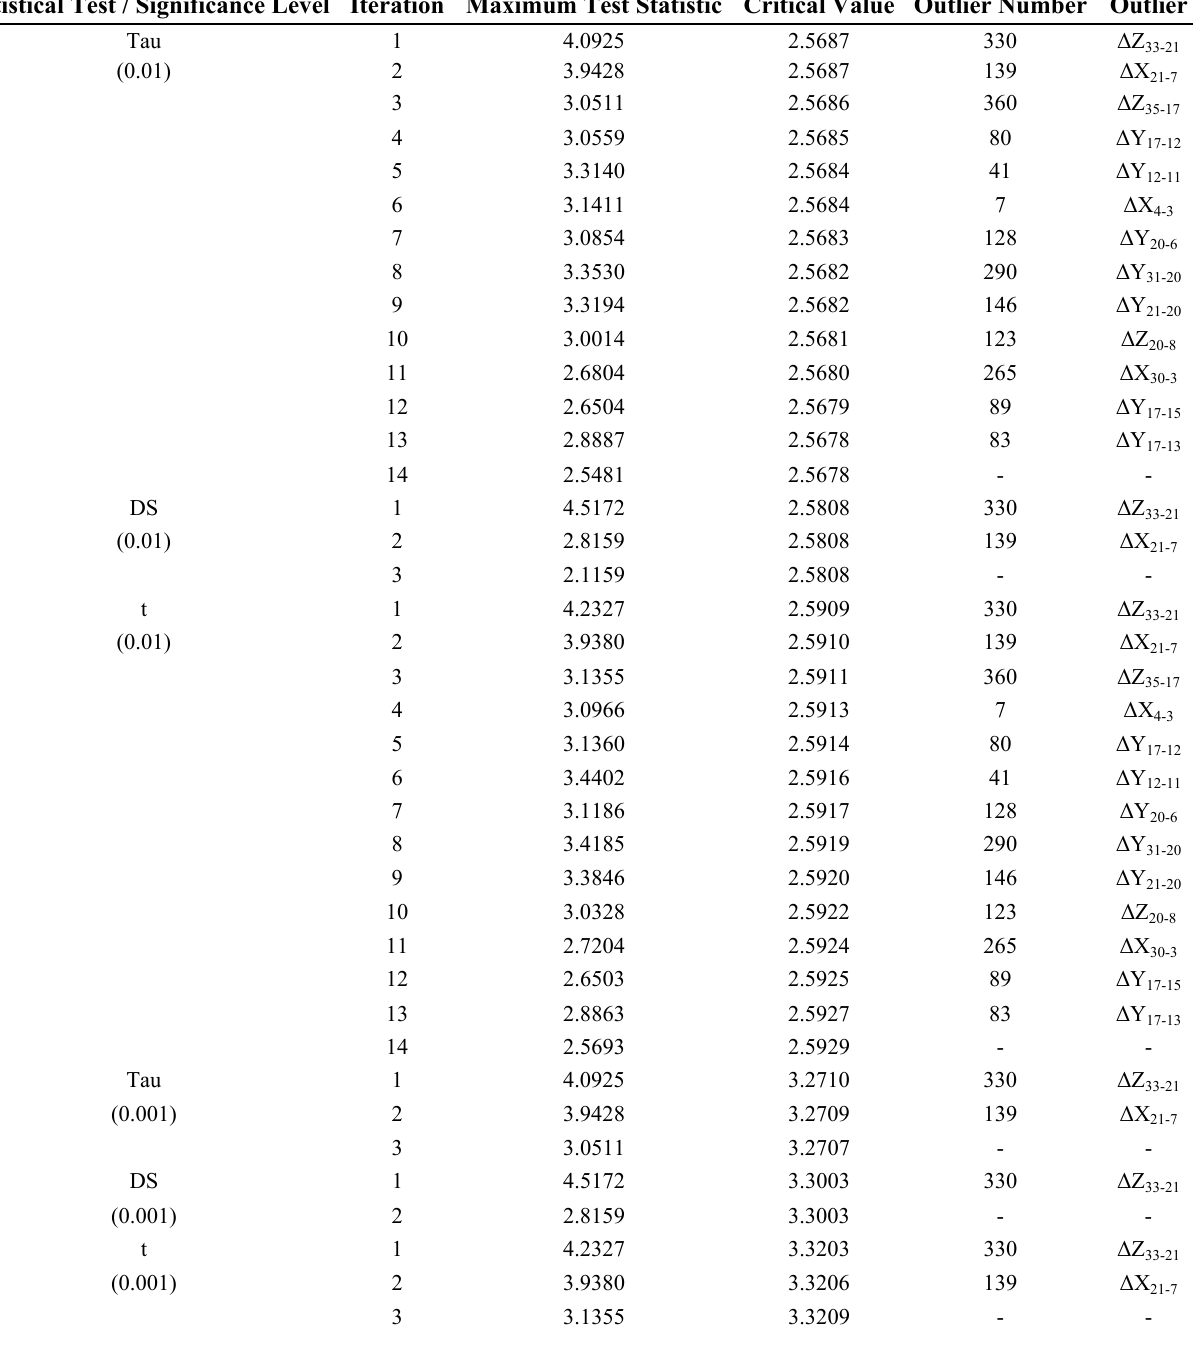
Table 5 Results of the conventional methods for the third GPS